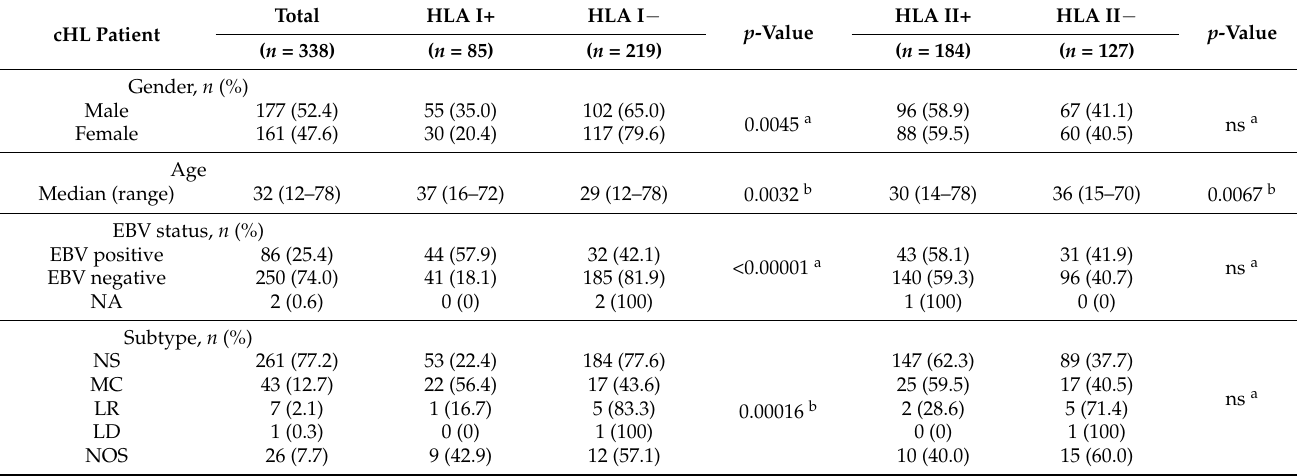
Table 1. Patient characteristics in total and HRS cell HLA expression status stratified subgroups.